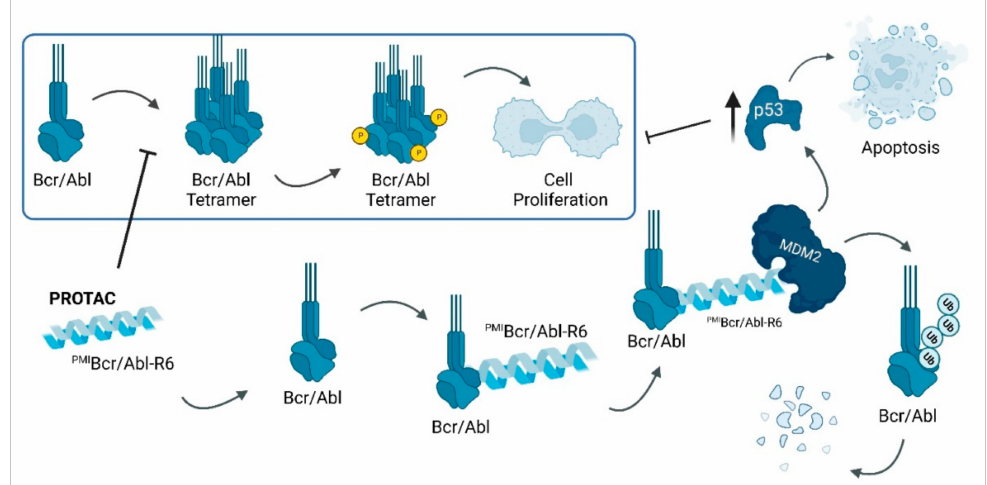
Figure 13. Mechanism of action of PROTAC PMI BCR/Abl-R6. In a normal situation, the Bcr/Abl protein tetramerizes and then phosphorylates, resulting in the activation of the signaling pathways that promote cell proliferation. In the presence of PROTAC, the Bcr/Abl protein is degraded and, therefore, does not tetramerize, preventing the activation of cell proliferation. On the other hand, the increase in tumor suppressor p53 promotes cellular apoptosis